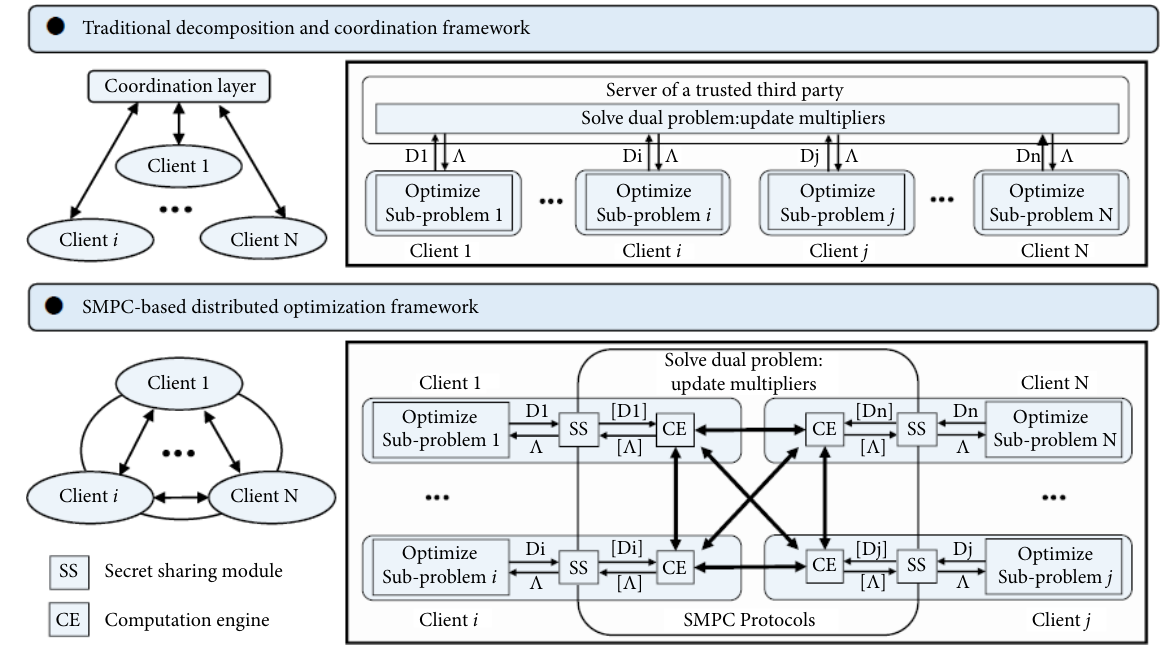
Fig. 1 Comparison on traditional hierarchical D&C framework and SMPC-based distributed optimization framework. The multiarea economic dispatch (MADE) of the power system is an important collaborative optimization problem in the real world, which needs to be executed in a distributed manner while preserving the private information of subgrids. To this end, a case study based on MAED with test systems on small and large scales is conducted to verify the effectiveness and efficiency of the pro- posed framework. The results illustrated that the proposed frame- work can not only provide global optimal solutions, but also assure no disclosure of the private information of any agent